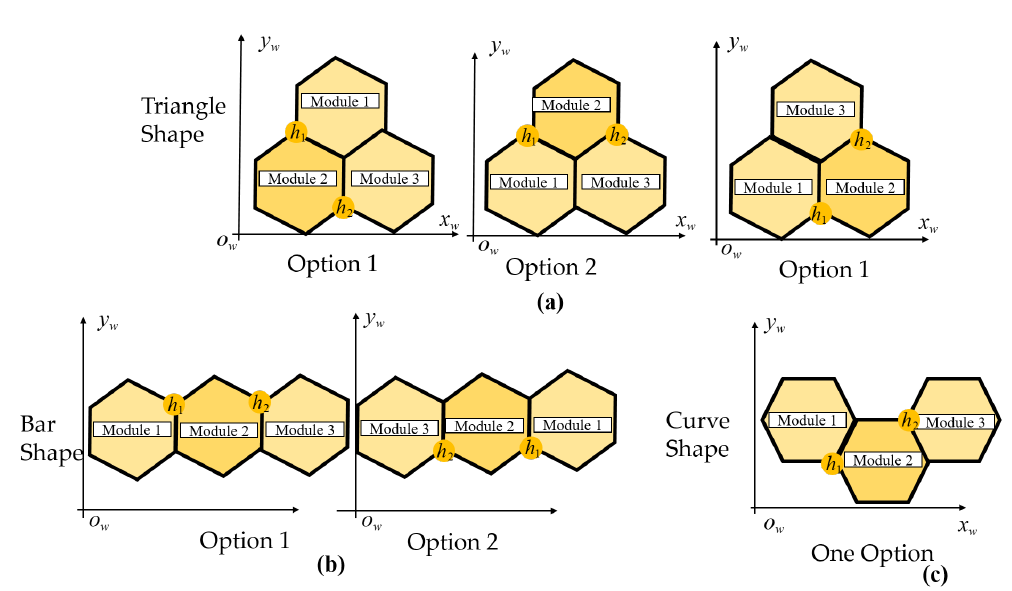
Figure 8. Module assignment for hTrihex inside the workspace: ( a ) Triangle shape; ( b ) Bar shape; and ( c ) Curve